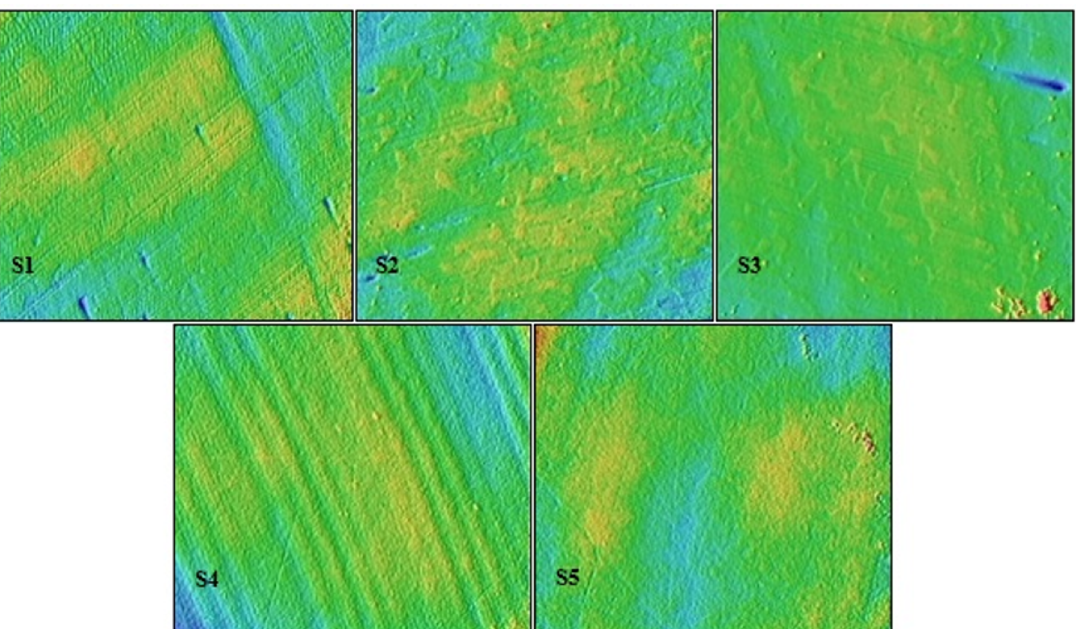
thin films obtained by Optical Confocal Microscopy, in a region with 300 µm length. Figure 3. Images of the TiO 2